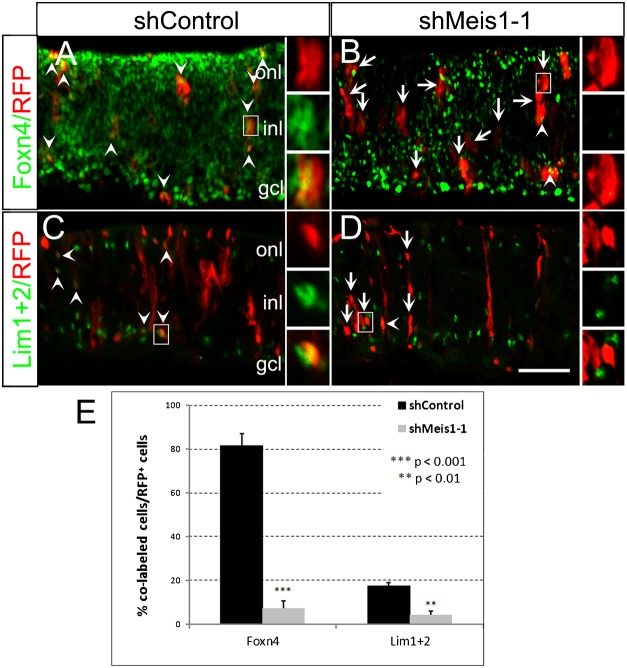
Knockdown of Meis1 reduces the expression of Foxn4 and Lim1+2.Chick retinas were electroporated with shMeis1-1 or shControl construct at E4. Transfected retina tissues were harvested at E7, sectioned, and immunostained for cell specific antibodies: Foxn4 and Lim1+2 (green). RFP+ cells show a dramatic reduction of Foxn4 and Lim1+2 expression in the shMeis1-1 (B,D) transfected cells, but not in the shControl transfected cells (A,C). Double labeled cells (Foxn4+/RFP+ or Lim1+2+/RFP+) were indicated by arrowheads, while arrows represent RFP+ cells that were negative with Foxn4 or Lim1+2 staining. A histogram (E) shows that there was a dramatic reduction of the percentage of RFP+ cells with Foxn4 and Lim 1+2 staining in shMeis1-1 transfected population. Error bars represent standard error of the mean. Each histogram represents the mean ± s.d.; n≥3. ONL, outer nuclear layer; INL, inner nuclear layer; GCL, ganglion cell layer. Scale bar: 20 µm.